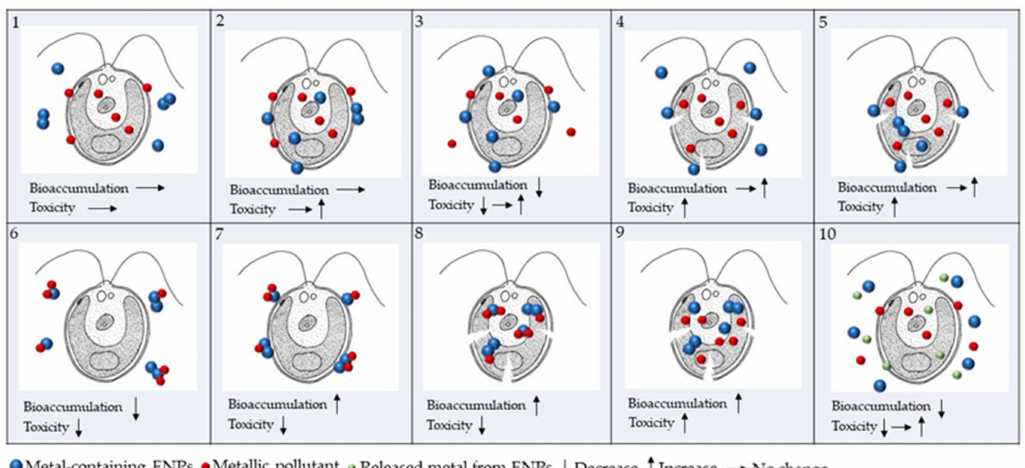
Figure 2. Conceptual presentation of di ff erent scenarios concerning combined e ff ects of mixtures of ENPs and metallic pollutants to “particle-proof” microorganisms like Chlamydomonas reinhardtii